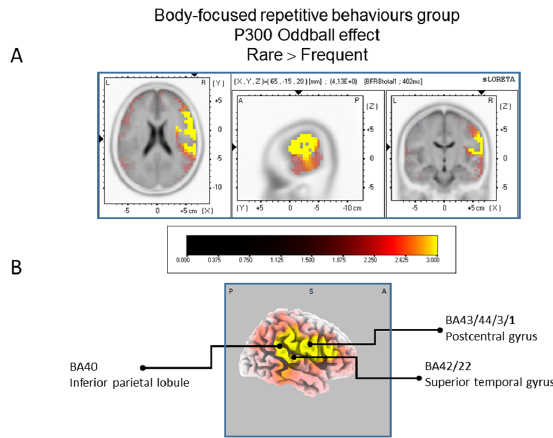
Figure 3. Results of the Body-focused Repetitive Behaviors patients based on the standardized low-resolution brain electrotomography (sLORETA) current source density localization of the oddball effect (contrast: “Rare”> Frequent”) in the peak activation of the P300 component within a 300–550 ms time window. Images have been obtained after statistical non-parametric mapping (SnPM) and co-registration to the stereotaxic Talairach space based on the Co-Planar Stereotaxic Atlas of the Human Brain [83] and the probabilistic MNI-152 template [81] Activated voxels are indicated by yellowish and reddish colors (after correction for multiple comparisons ( p < 0.01 and p < 0.05, respectively)). ( A ) The peak of highest cortical activity has been found in parts of the inferior parietal lobule (BA40), the postcentral gyrus (BA43/3/1) and the superior temporal gyrus (B42/22). ( B ) A shifted lateral view of the right hemisphere, showing cortical activations on the three-dimensionally rendered Colin27 template [89]. A, anterior; P, posterior; MNI, Montreal Neurological Institute; X, Y, Z, corresponding MNI coordinates; BA, Brodmann area. Brain Sci. 2017 , 7 , 76